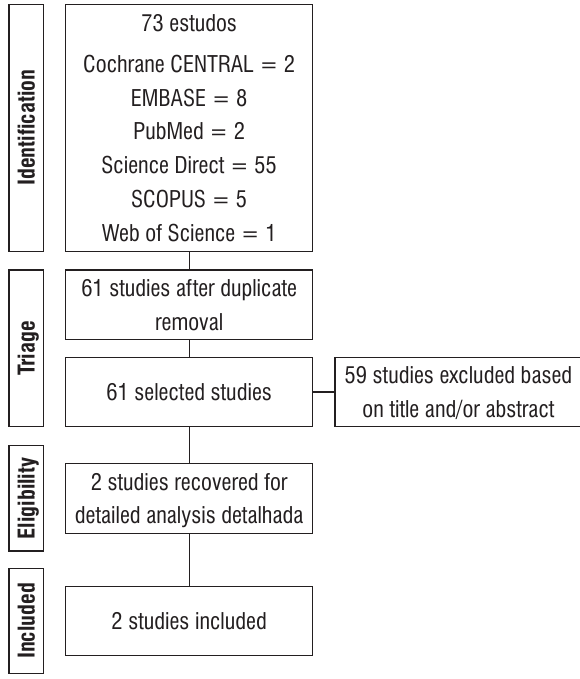
Figure 1 - Search